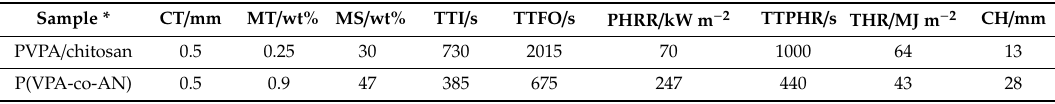
Table 3. Tape-pull test, water-soak test and cone calorimetric data for PMMA substrates with crosslinked VPA / chitosan and VPA / AN